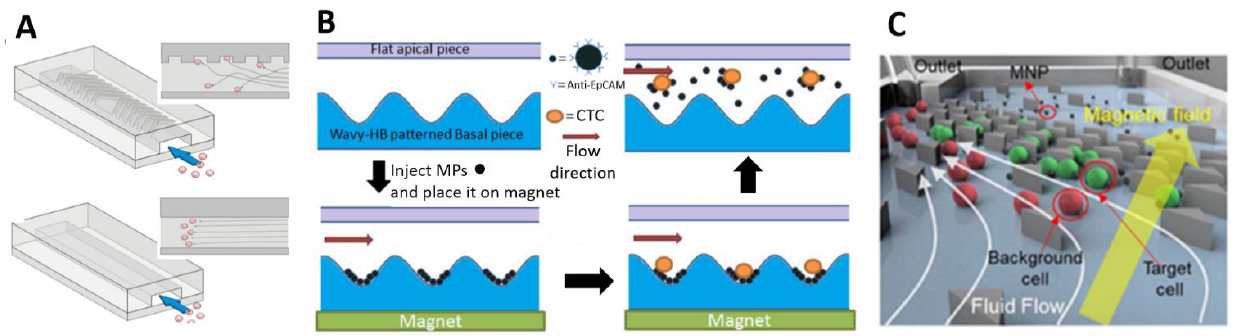
Figure 12. Macroscale permanent magnets combined with microstructured channels ( A ) Principle of advective transport with herringbone pattern. Reprinted from [174]. ( B ) Schematic of the principle of CTCs trapping in wavy herringbone. Reprinted from [177] with the permission of Royal Society of Chemistry; permission conveyed through Copyright Clearance Center, Inc. ( C ) Schematic of magnetic labeled cell trapping in a micropillar array. Reprinted with permission from [178] © IOP Publishing.